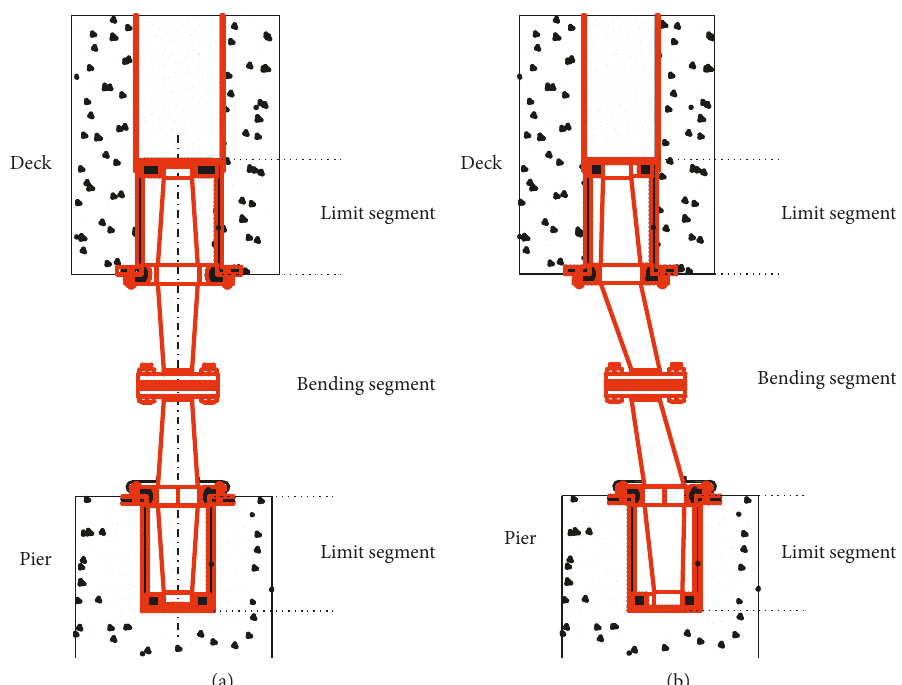
Figure 2: Schematic diagram of the working conditions of the shock-absorbing device. (a) Deformation diagram of the shock-absorbing device with small displacement. (b) Deformation diagram of the shock-absorbing device with large displacement.